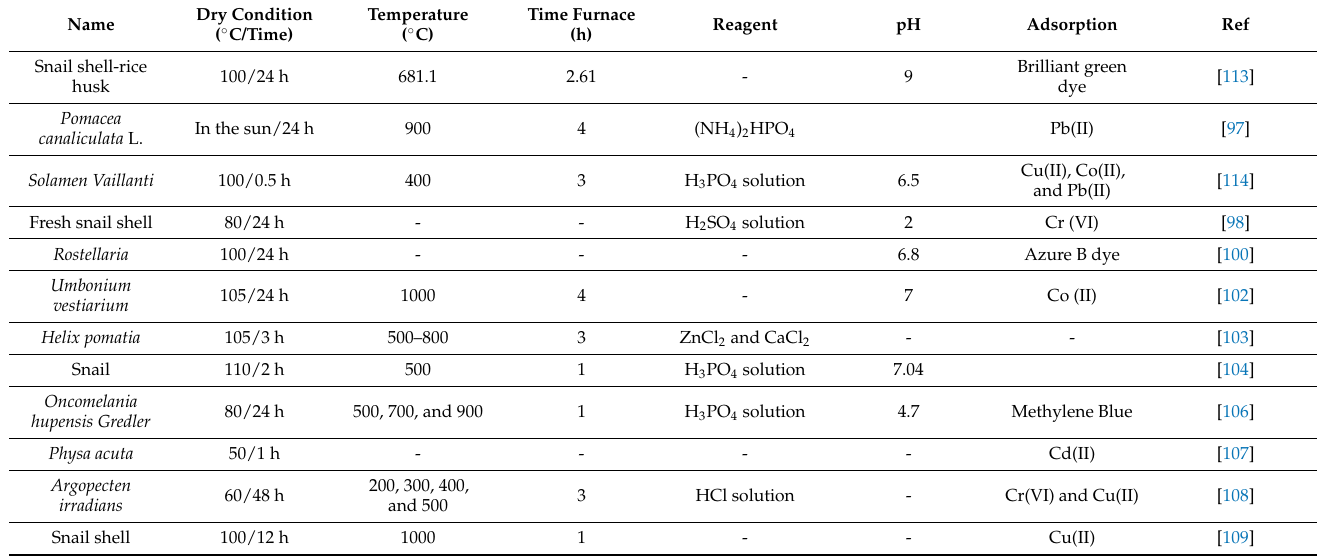
Table 3. Snail shell material processing